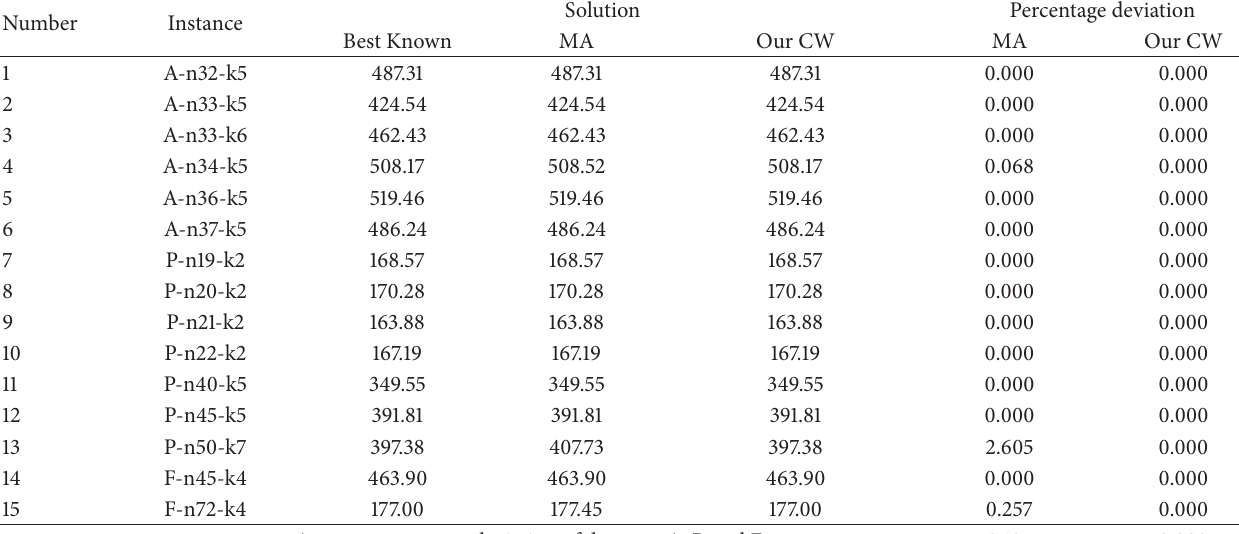
Table 4: Computational results between the proposed CW and MA for data sets A, P, and